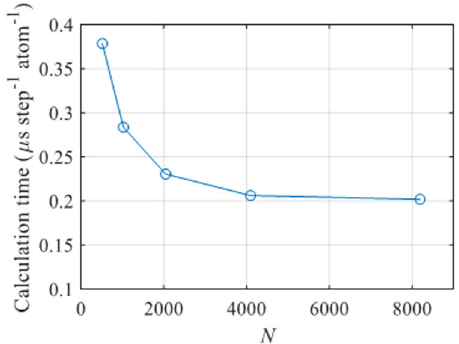
Fig. 7 The calculation time ef fi ciency depending on the number of atoms. N denotes the number of atoms in the GeTe